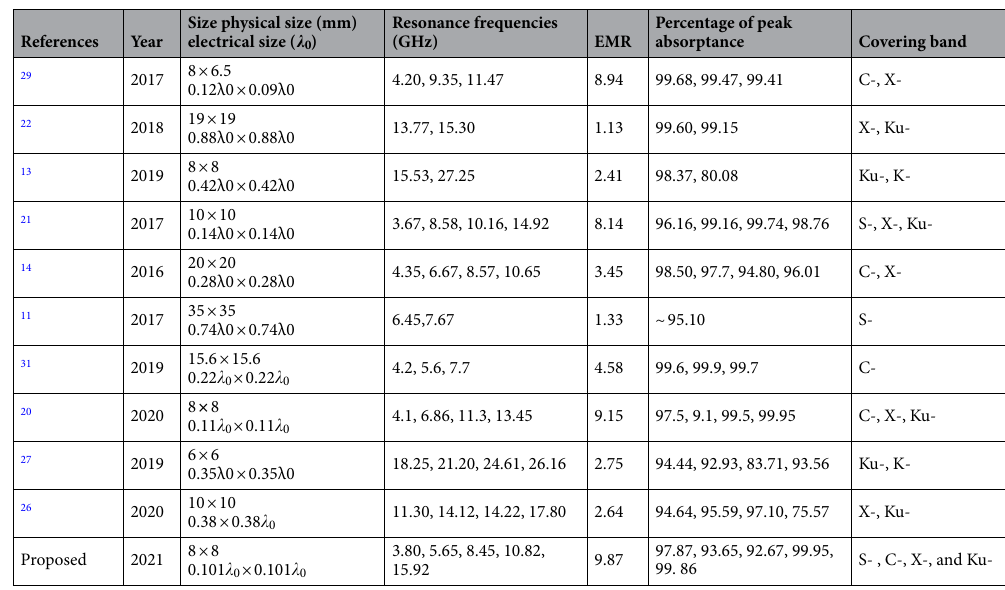
Table 11. Comparison of performance among proposed MAA unit cell and some other published MMA unit